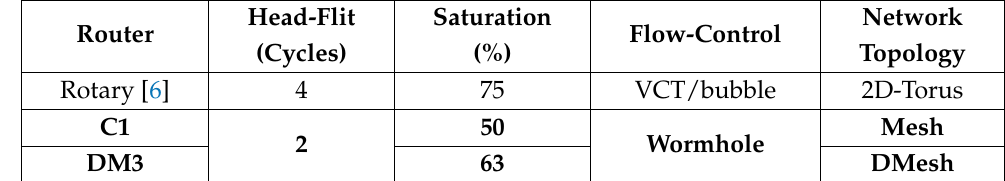
Table 6. Comparison with Rotary.